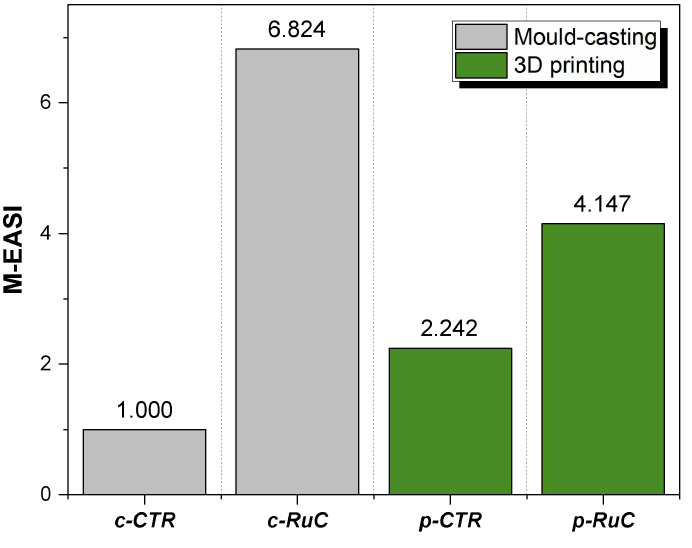
Figure 6. M-EASI analysis